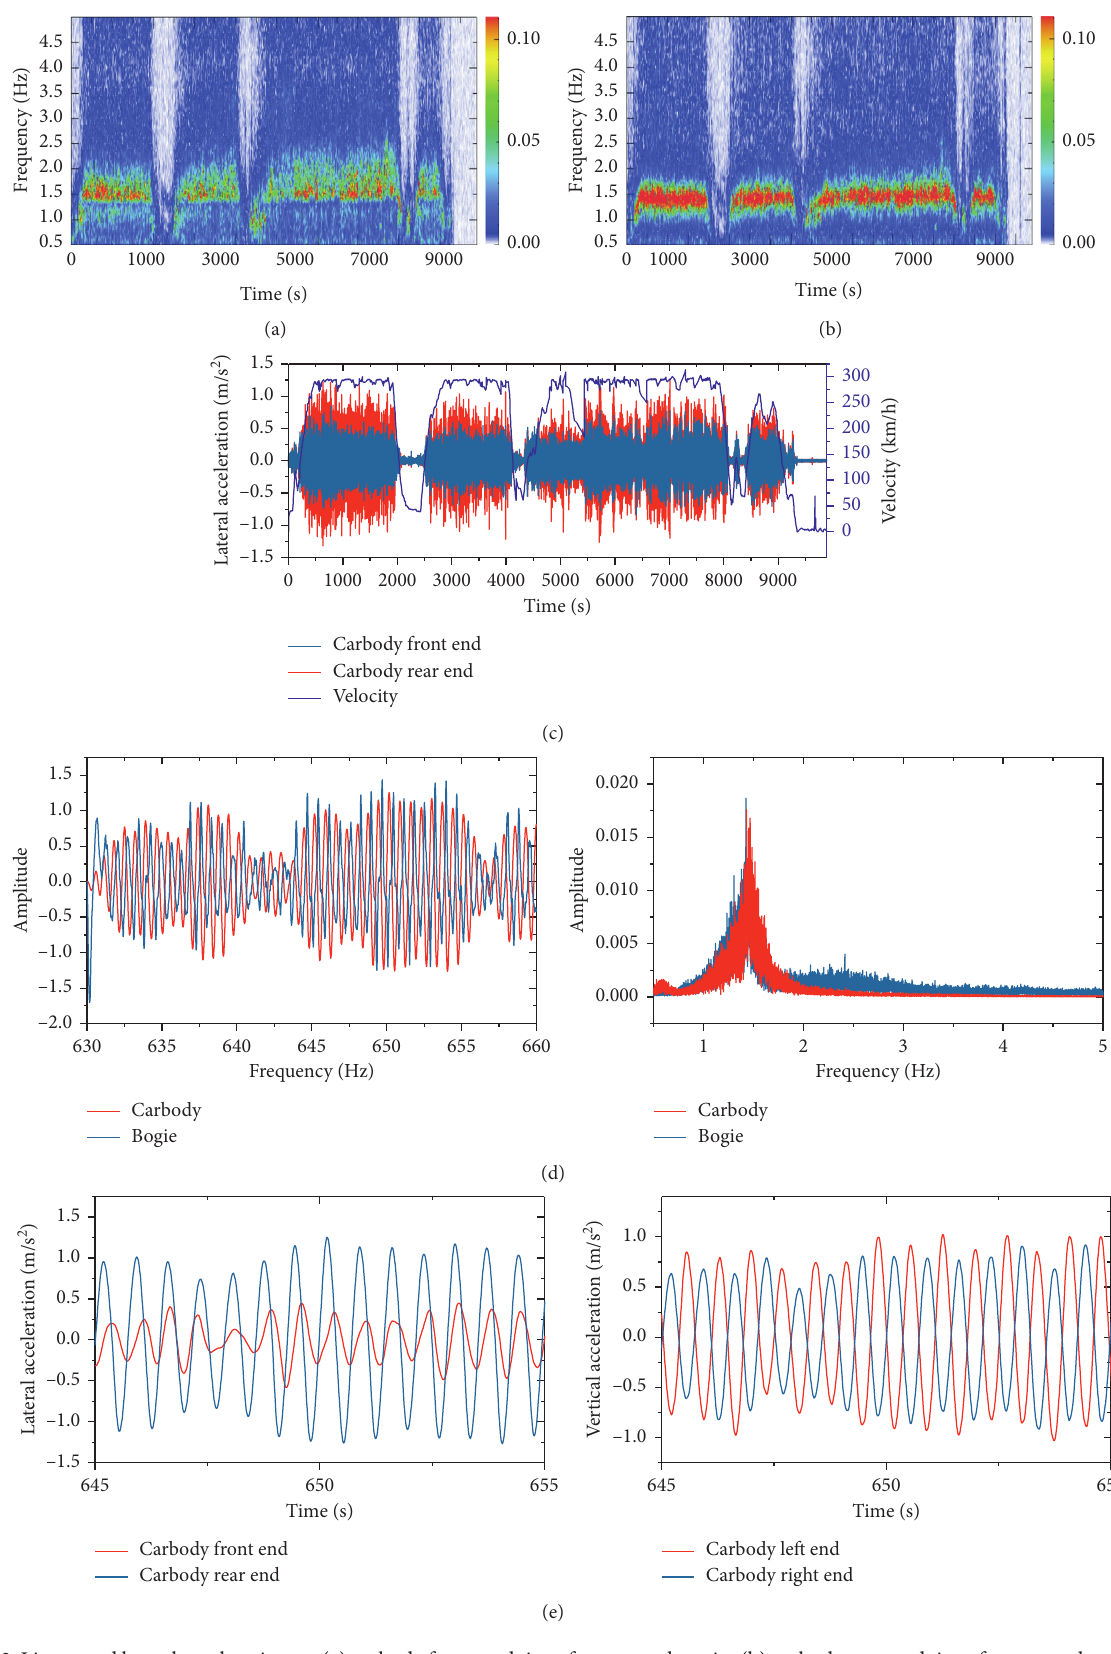
Figure 2: Line tested lateral acceleration on (a) carbody front-end time-frequency domain, (b) carbody rear-end time-frequency domain, (c) time domain (0.5–3Hz), (d) carbody and bogie in time and frequency domain, and (e) carbody vibration